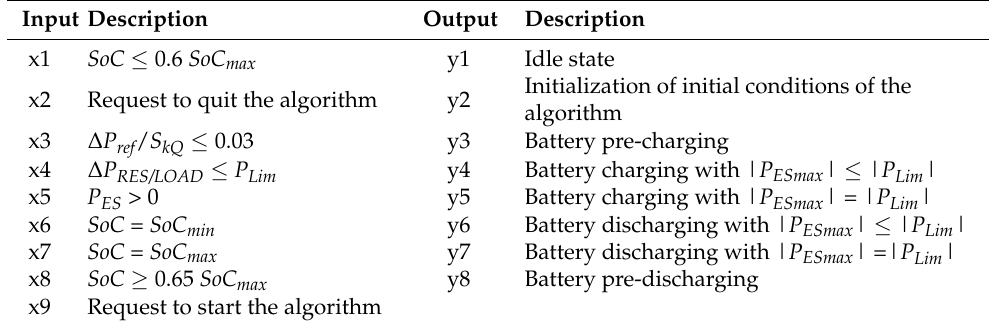
Figure 4. An interpreted Petri net describing the overall supervisory energy management system of the algorithm for power stabilization of RES/LOAD with all input signals assigned, prepared to be used in a rule-based logical model. Table 1. Binary input and output